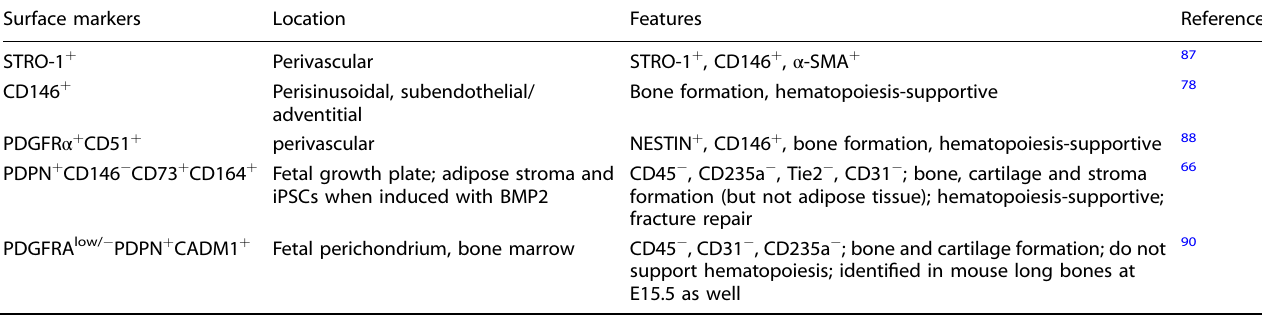
Table 2. Human skeletal stem cells labeled by immunophenotypic markers Surface markers